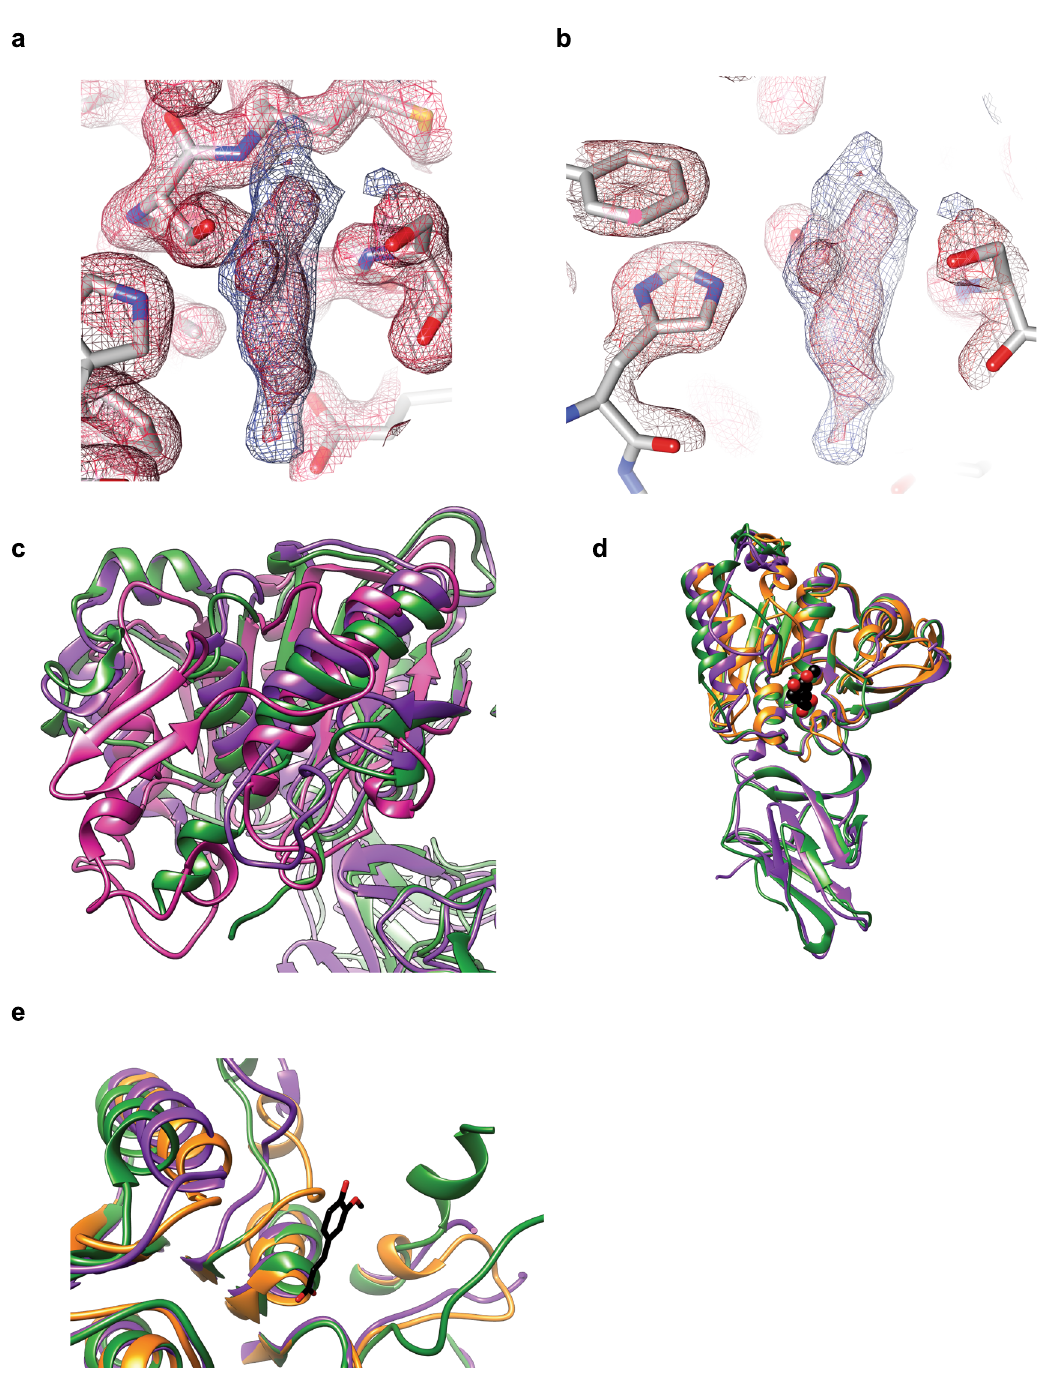
Fig. 6 Structure comparisons of the Bacteroides esterase enzymes. a , b , Close-up view of the unidenti fi ed solvent density at chain B of the Bi1039-CE1 structure. The F o – F c map is displayed in blue and contoured at 3.5 σ while the 2Fo-Fc for the surrounding residues is shown in red and contoured at 1.5 σ . Maps were calculated in Phenix and rendered in Chimera. c Overlay of the C-terminal domain of the BeGH43/FAE enzyme (pink) with Bi1033-CE1 (green) and Bi1039-CE1 (purple). d Overlay of the Bi1033-CE1 (green), Bi1039-CE1 (purple) and the ferulic acid esterase domain of cellulosomal xylanase Z from Clostridium thermocellum with ferulic acid (yellow, PDB 1JT2). Ferulic acid bound to xylanase Z is shown in black and red spheres. e Close-up view of the active sites from a superposition of Bi1033-CE1 (green), Bi1039-CE1 (purple) and the ferulic acid esterase domain of cellulosomal xylanase Z from C. thermocellum with ferulic acid (yellow, PDB 1JT2). Ferulic acid bound to xylanase Z is shown in black and red